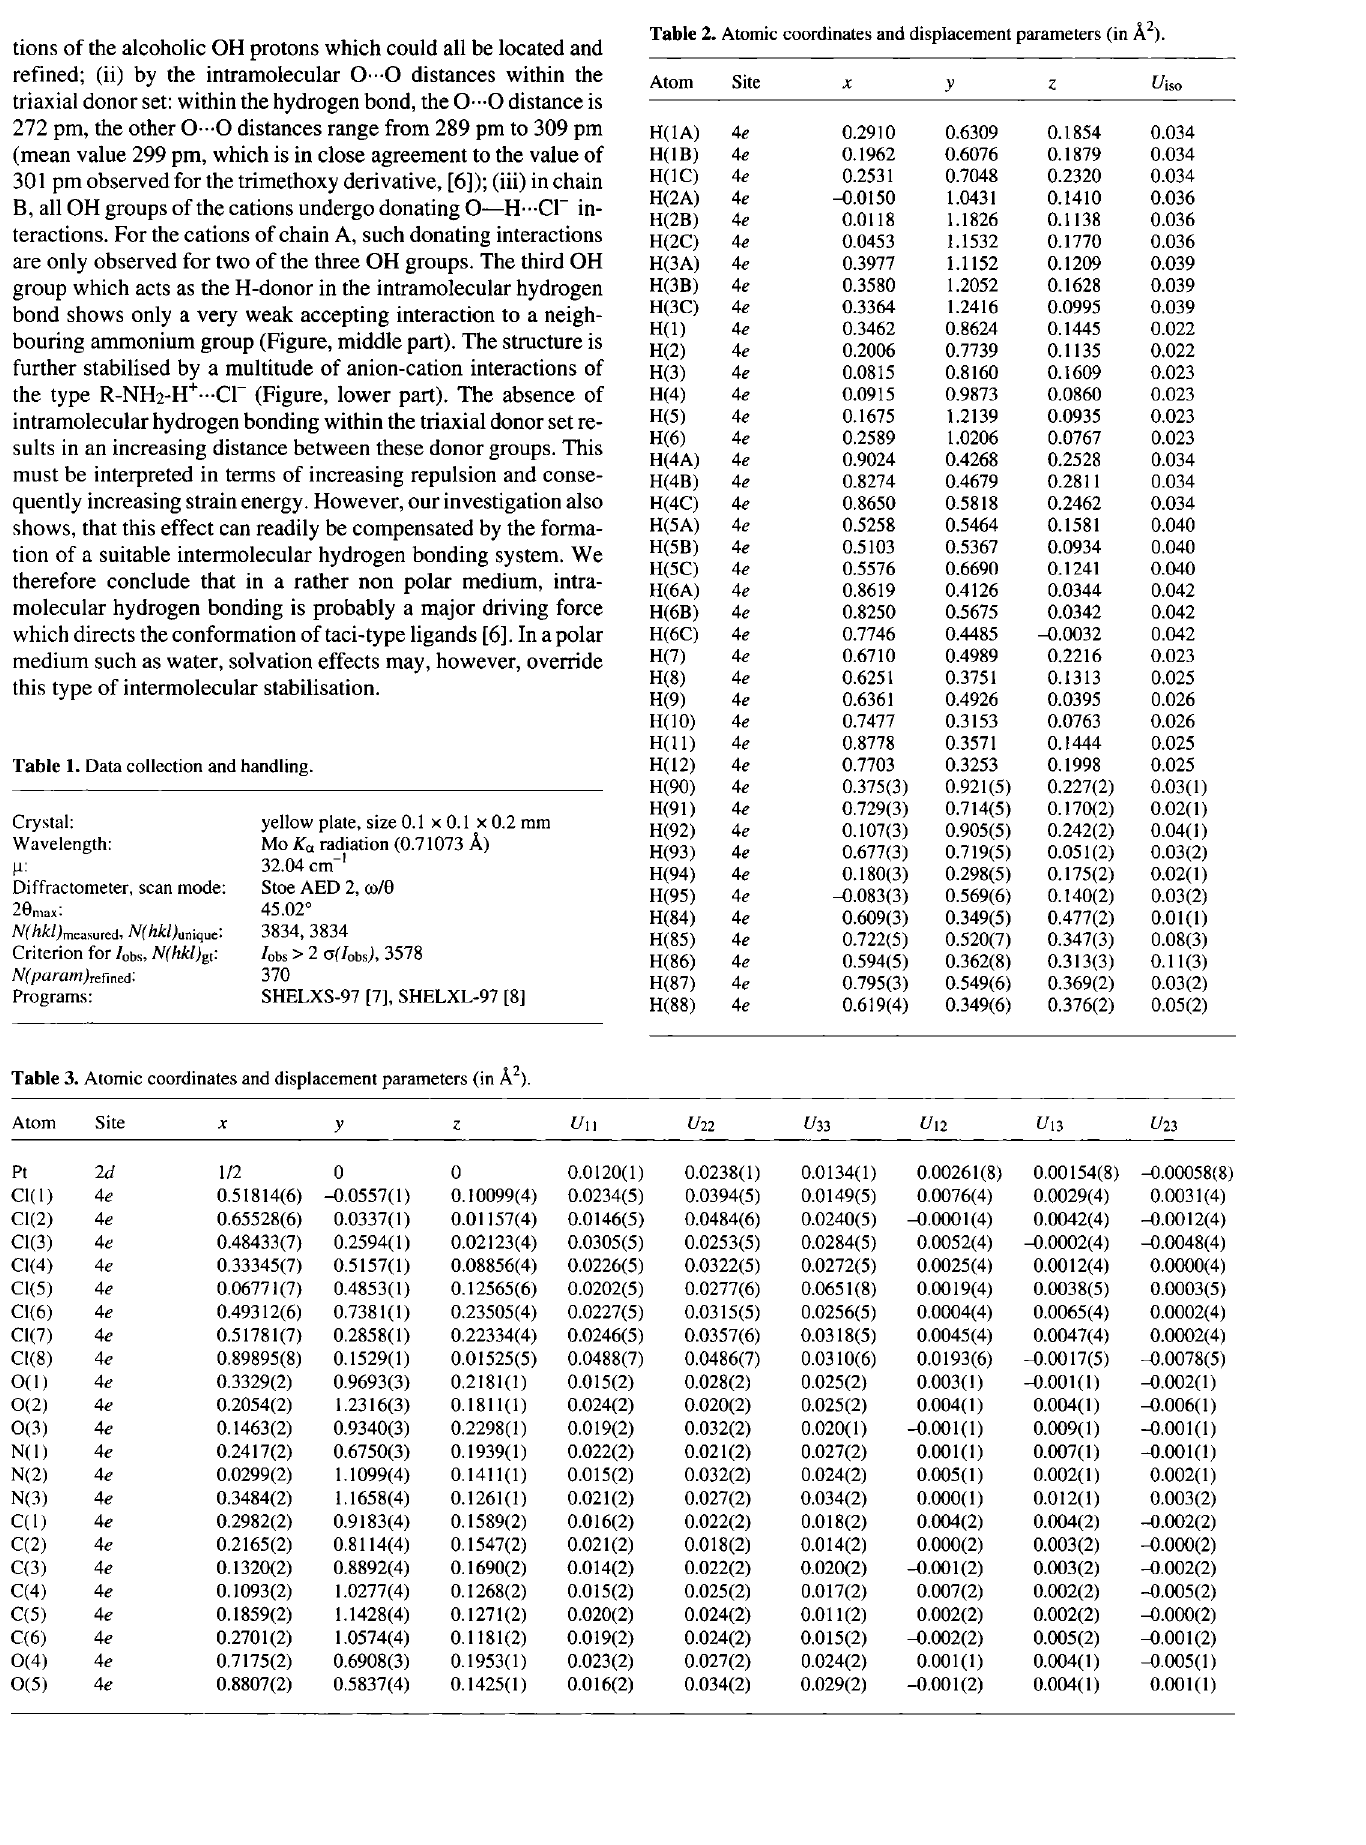
Table 3. Atomic coordinates and displacement parameters (in Ä 2